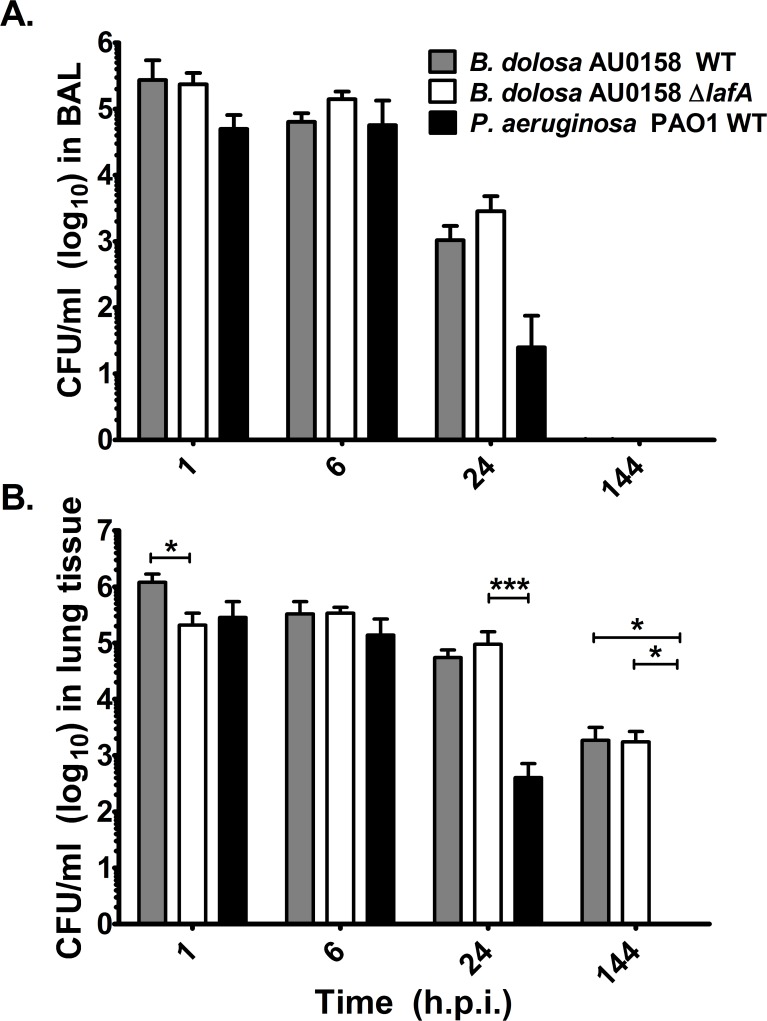
Bacterial survival in murine pneumonia model.C57BL/6 mice were inoculated intranasally with 5 x 106 CFU/mouse and observed over time. At indicated times, the BAL fluid (panel A) was collected and the lungs homogenized (panel B), serially diluted, and plated for bacterial counts. Error bars represent one standard deviation of the data from 4–5 mice/group. Significant differences were assessed using one-way ANOVA. Asterisks indicate strain-based differences assessed using the Tukey’s multiple comparison test. *p < 0.05, ***p < 0.001. There were no significant differences between strains in panel A. The levels of bacterial survival in the wild-type controls was published previously [50] as the bacterial survival analysis of the B. dolosa lafA deletion mutant was completed as part of a larger study.